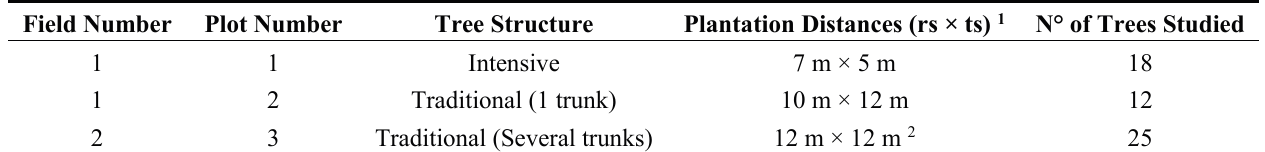
Table 1. Main characteristics of parcel and trees selected for trials.